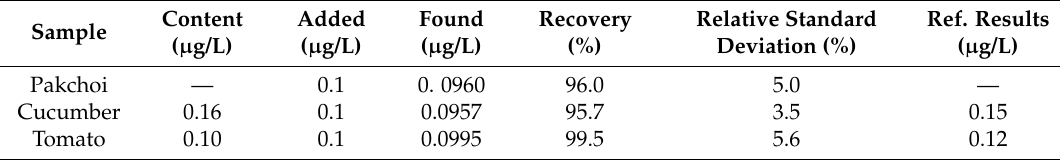
Table 5. Determination results of ACT in water